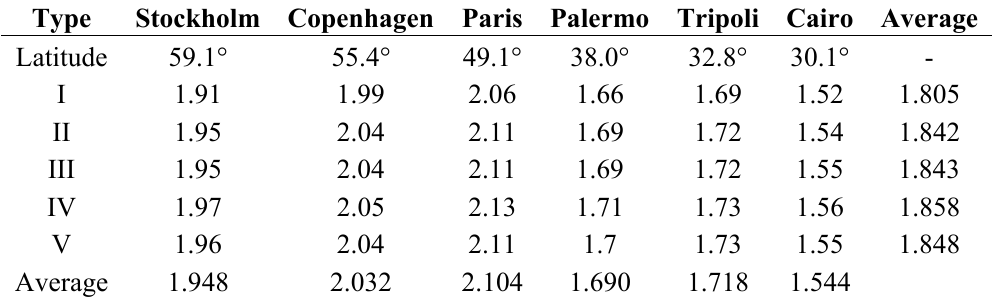
Table 5. Power ratio between P PVpeak / P nINV_DC for some solar inverters and for different latitudes. Type Stockholm Copenhagen Paris Palermo Tripoli Cairo Average